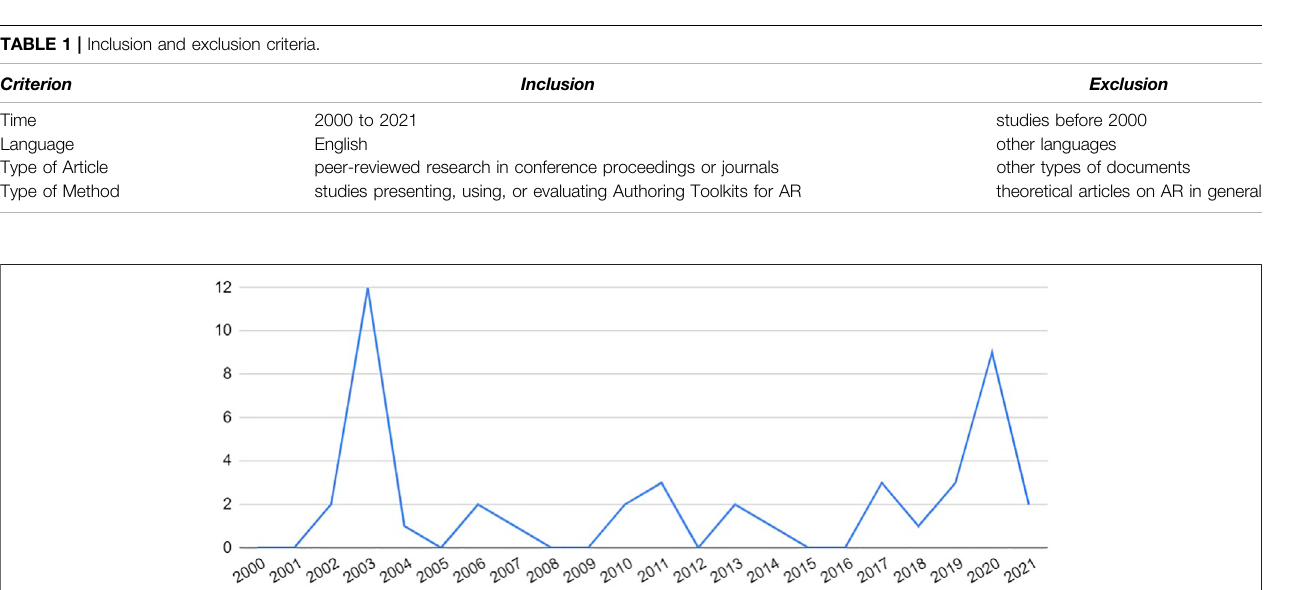
Frontiers in Virtual Reality |